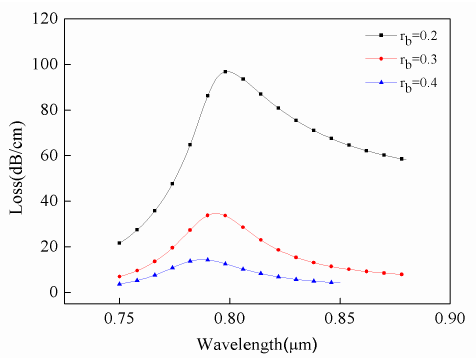
Figure 5. Loss spectra of different outer air hole radii. Conditions: r a = 0.6 μ m, r g = 0.2 μ m, and n = 1.34.